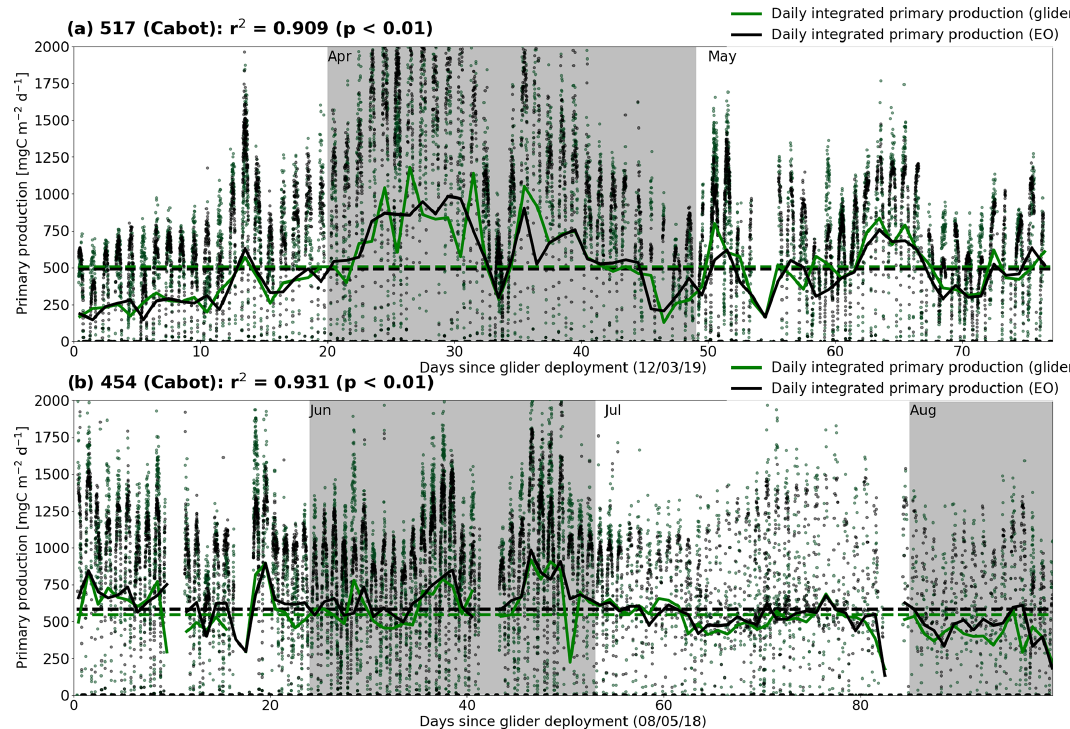
Figure 8. Comparison of net primary production estimates from the in situ PAR method (green points and traces) and SEO-based PAR method (black points and traces) for glider Cabot missions (a) 517 and (b) 454. Points represent the instantaneous measurements taken from individual profiles, with solid traces showing the daily integrated values. Mean daily values for each mission and method are given by the respective dashed lines. The r 2 statistic is calculated between the individual profile values for the two methods.